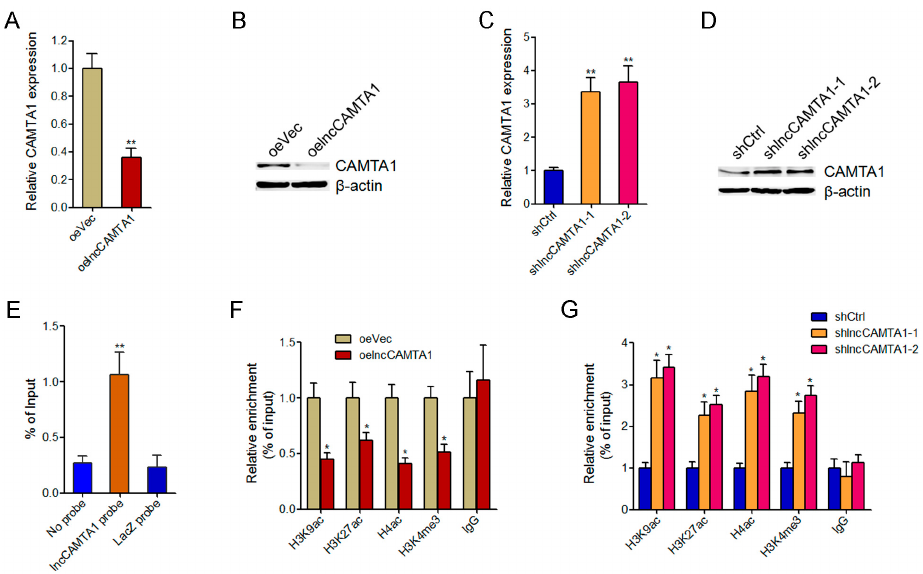
Figure 6. lncCAMTA1 inhibits CAMTA1 expression via changing chromatin structure at the CAMTA1 promoter. ( A ) CAMTA1 mRNA levels in HCCLM3 cells stably overexpressing